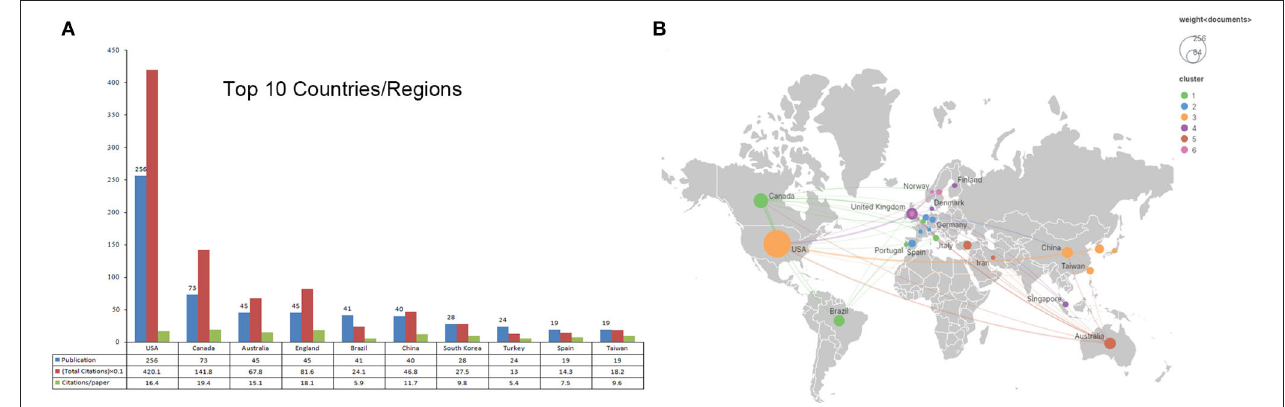
FIGURE 4 | The top 10 prolific countries/regions and inter-national collaboration network on virtual simulation in nursing research. (A) The number of publications, total citations, and citations per paper in top 10 countries/regions. (B) The co-authorship network visualization map of countries for virtual simulation in nursing research. Node size indicated the number of articles produced. The distance between any two nodes positively associated with the cooperation strength. The color indicated the average publication year for the author, The blue color represented for early stage and yellow color represented late stage.